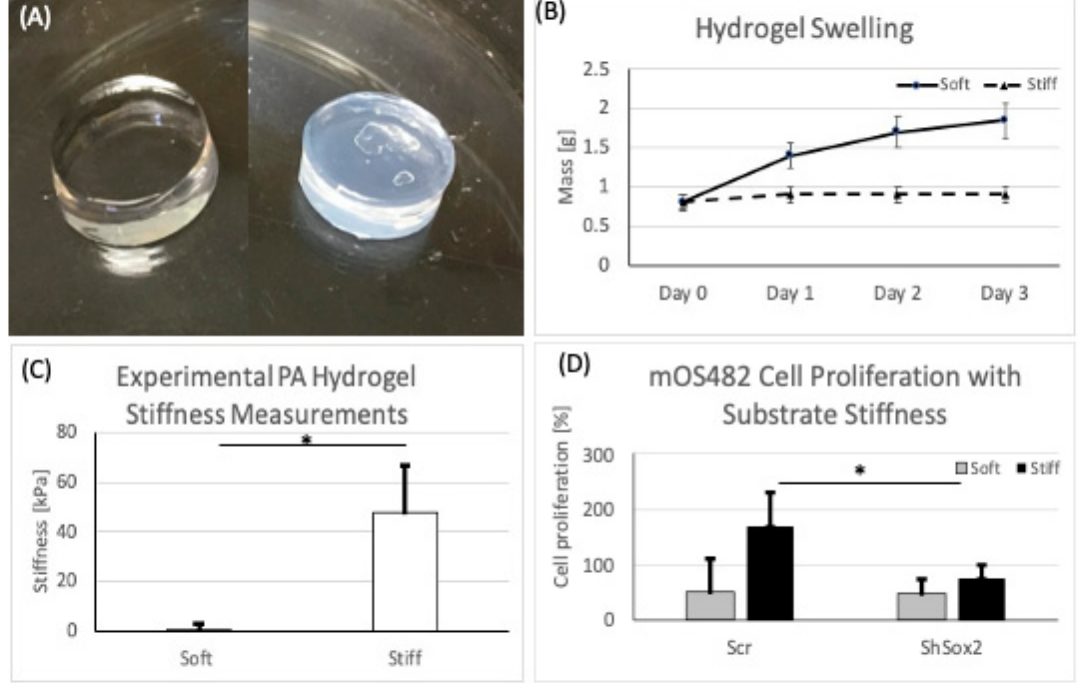
Figure 4. Physical characterization of PA hydrogels and cell proliferation. ( A ) Representative images of soft and stiff PA hydrogels before testing. ( B ) Swelling properties of PA hydrogels over 3 days. ( C ) PA hydrogel stiffness measurements. ( D ) OS cell proliferation on soft and stiff substrates. * p < 0.01; p value from Mann–Whitney test for statistical significance.